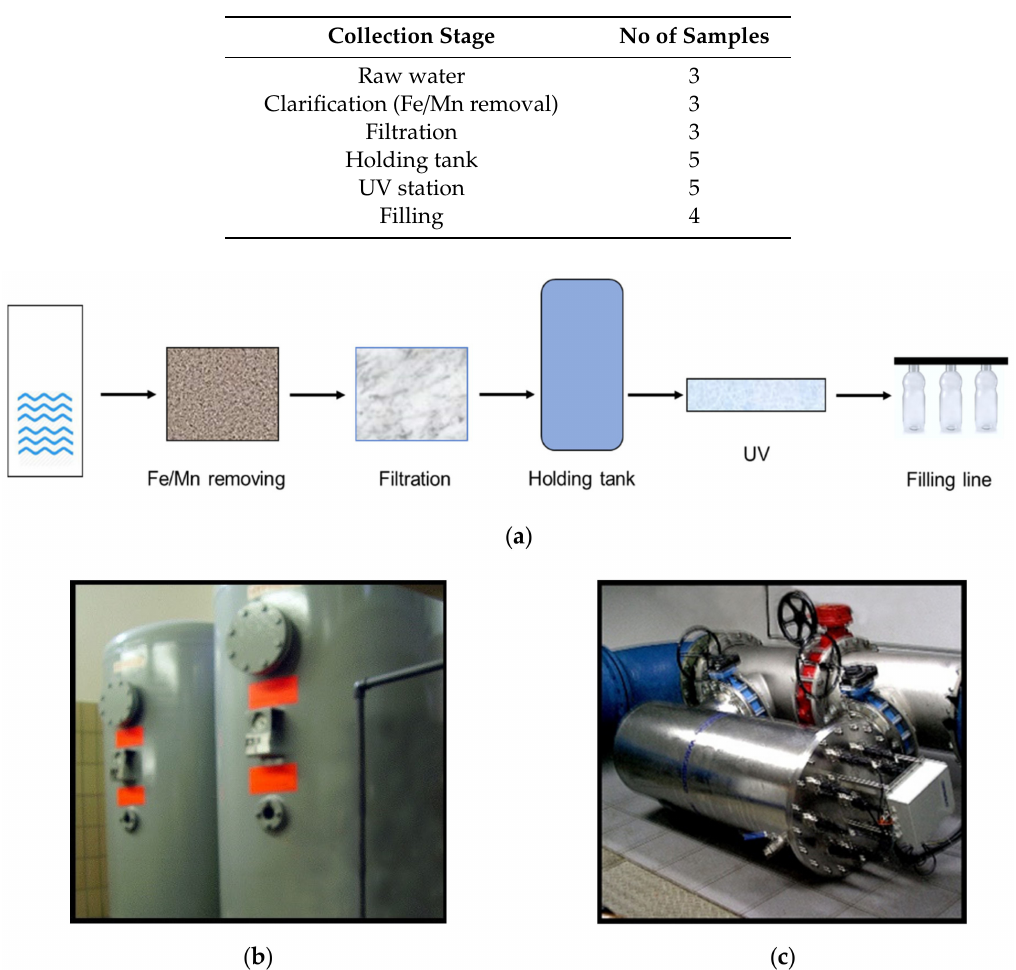
Figure 1. Bottled water processing: ( a ) general scheme; ( b ) holding tank; ( c ) UV station.